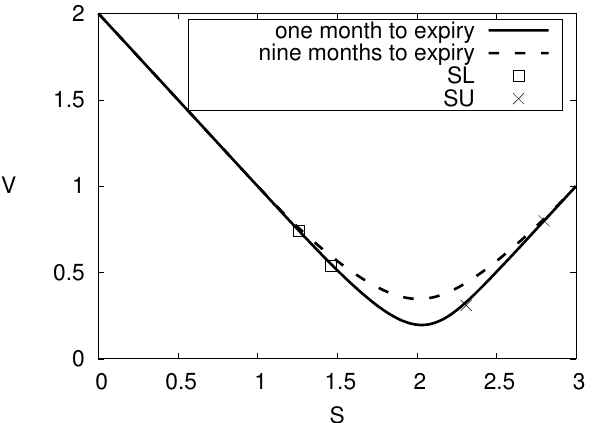
Figure 1. American straddle prices with parameters X = 2, σ = 0.2, r = 0.03, q = 0.04 for τ = 1/12 and τ = 9/12.